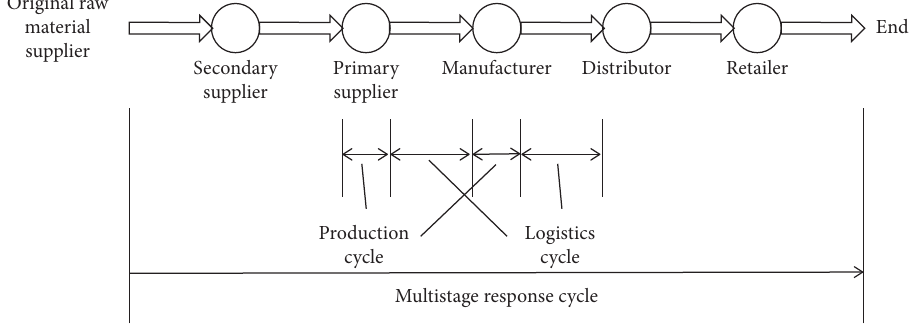
Figure 2: Multistage response cycle model of supply chain.